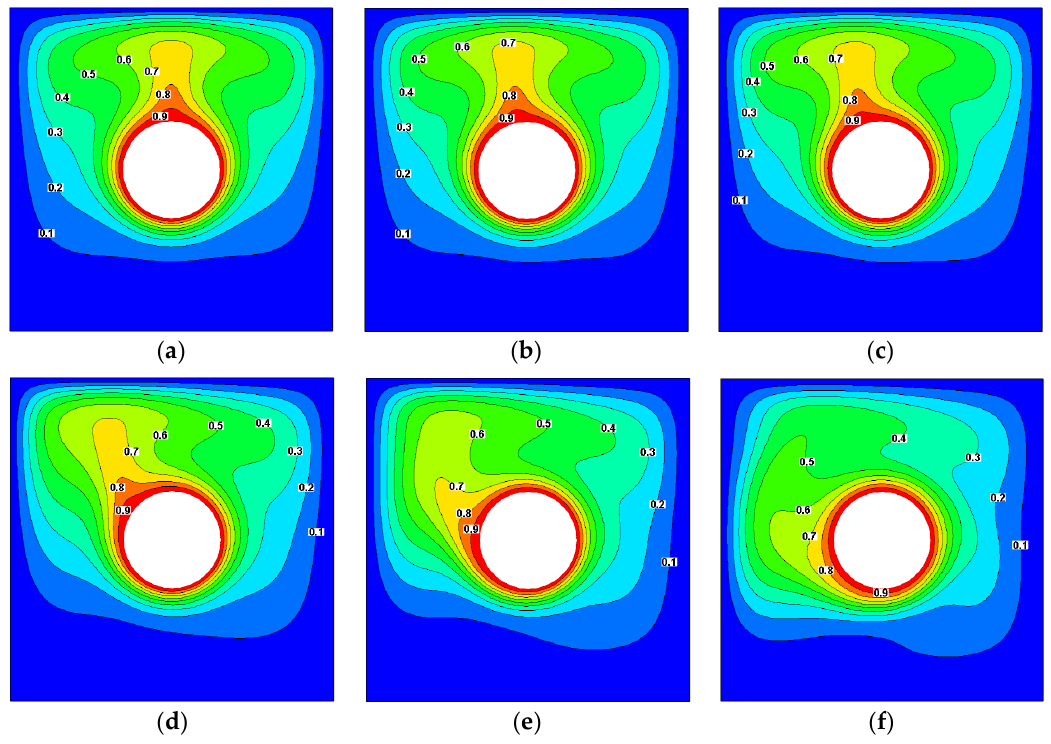
Figure 11. ( a ) N = 0, ( b ) N = 10, ( c ) N = 20, ( d ) N = 50, ( e ) N = 100, ( f ) N = 200. Contours of dimensionless temperature at λ = 0.3, Ha = 40 and Ra = 10 6 .